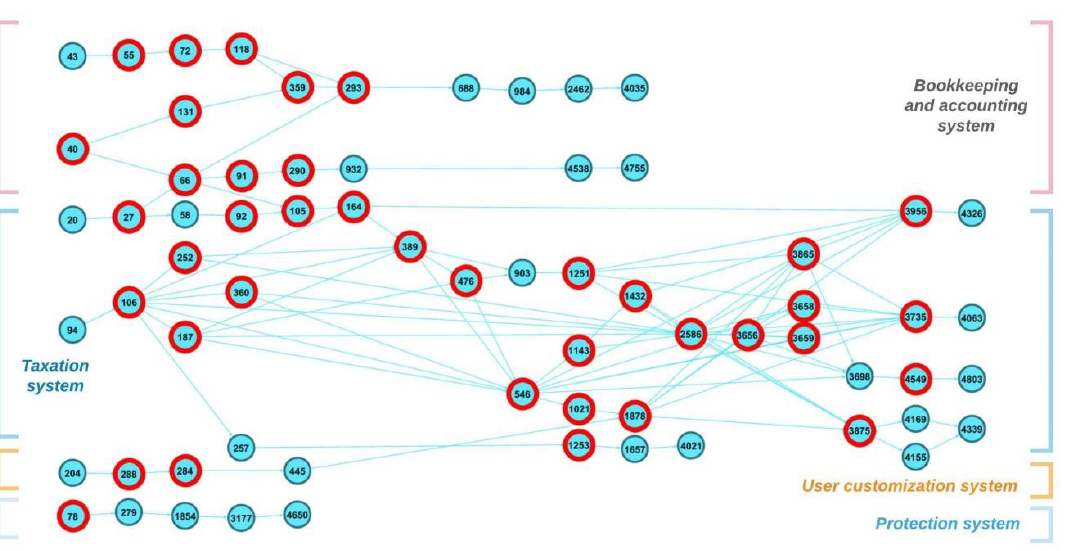
Figure 2. Knowledge persistence-based main paths for accounting information systems. Note : dominant knowledge patents are marked with red color.